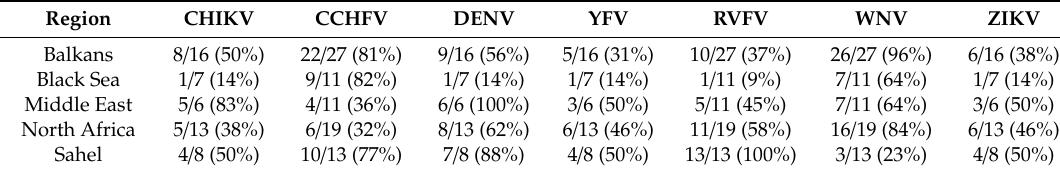
Table 4. Regional relevance of the investigated pathogens.